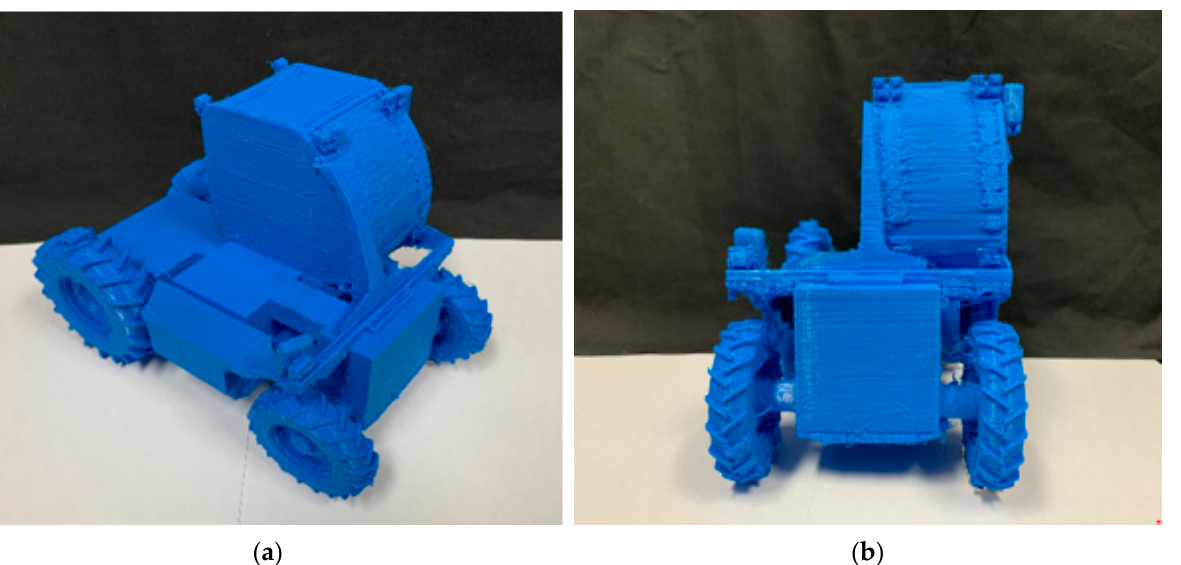
( d ) Figure 5. Overall dimension and relative position of the gravity center for the original and 1/20 scale- down miniature model: ( a ) Length and width ratio of the original model; ( b ) Length and width ratio of the miniature model; ( c ) Height ratio of the original model; ( d ) Height ratio of the miniature model.